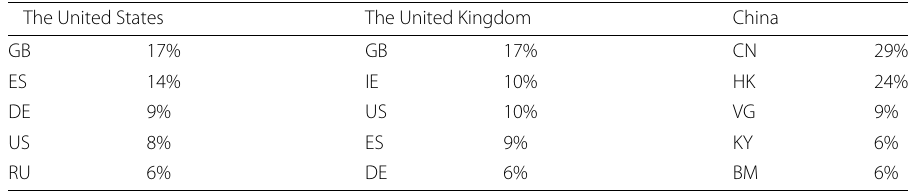
Table 9 “Conduit” companies of top three